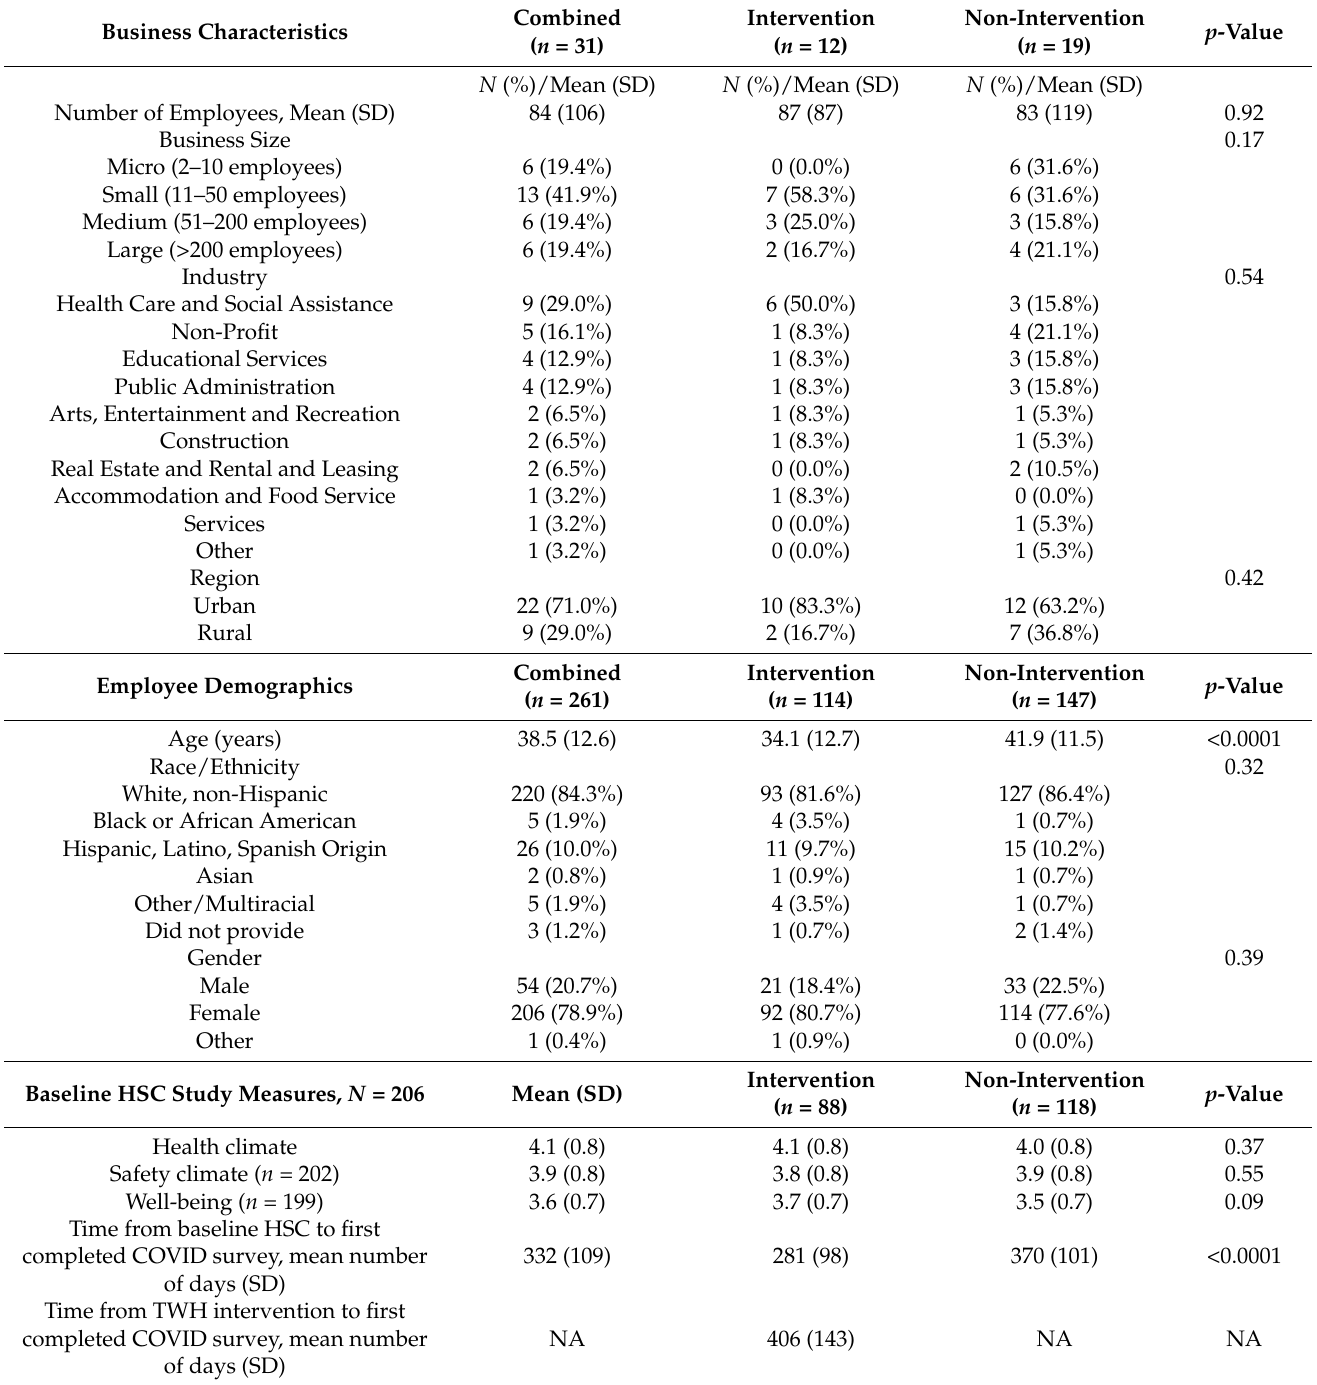
Table 1. Business characteristics and employee demographics by intervention